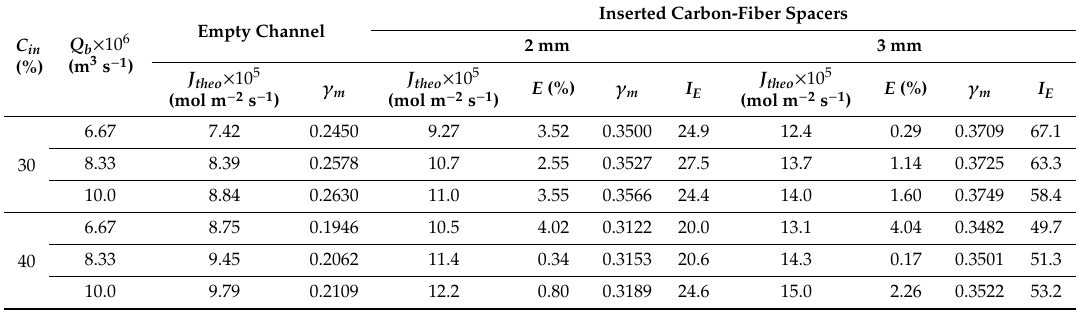
Table 2. E ff ects of operating condition and spacers’ width on γ m for countercurrent-flow operations.